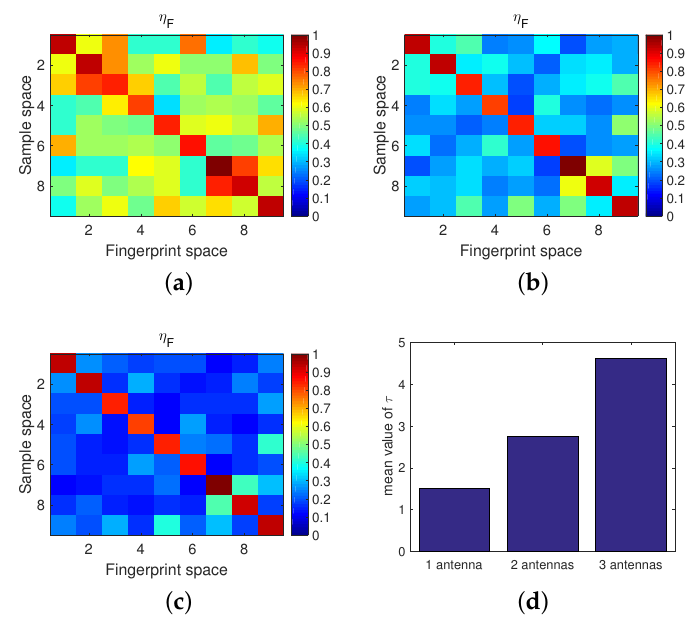
Figure 9. Influence of the communication link number on performance. ( a ) one receiving antenna. ( b ) two receiving antennas. ( c ) three receiving antennas. ( d ) Spatial-temporal focusing metric